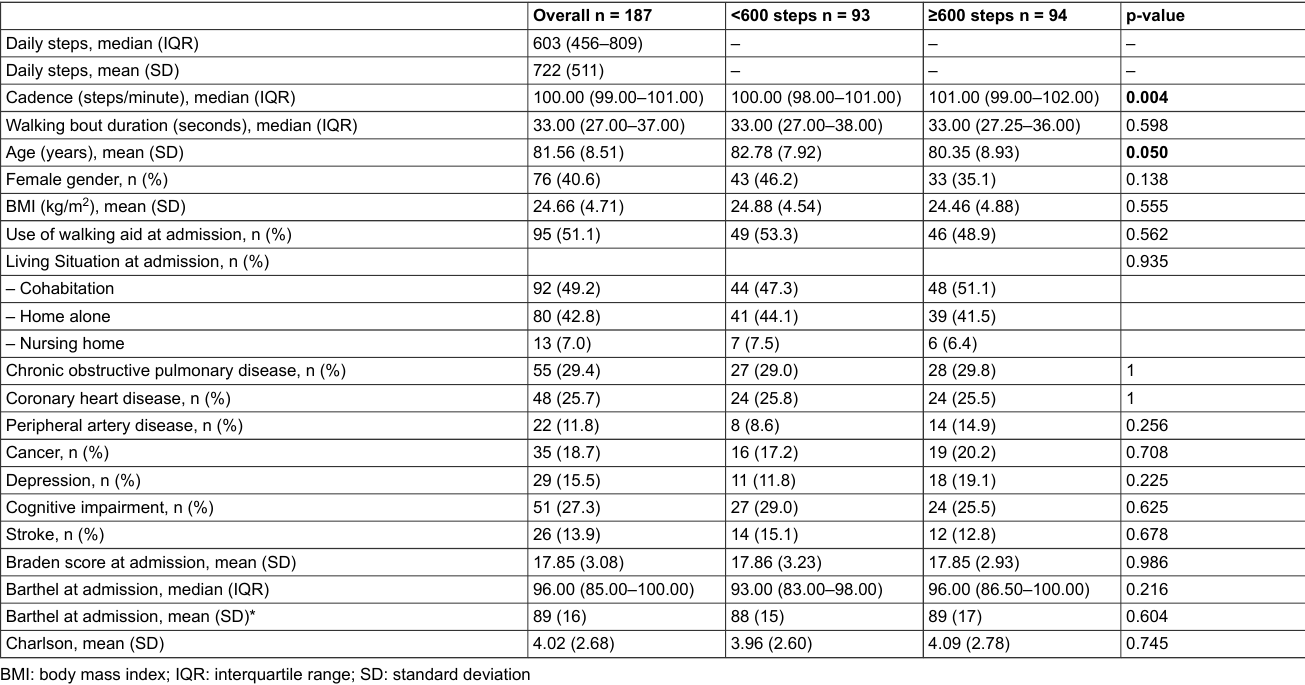
Table 1: Baseline characteristics of the study sample, stratified by the median number of steps.